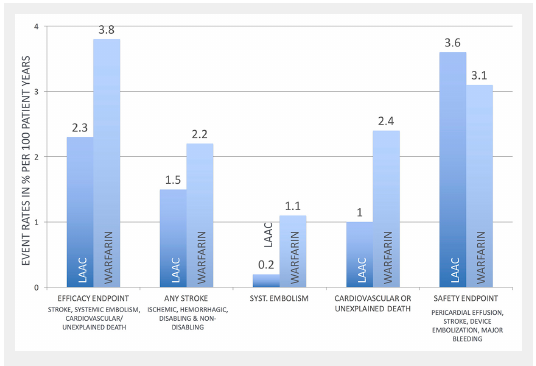
Primary outcomes of the Percutaneous Closure of the Left Atrial Appendage Versus Warfarin Therapy for Prevention of Stroke in Patients with Atrial Fibrillation (PROTECT AF) study [54]. In comparison with warfarin, left atrial appendage closure (LAAC) with the Watchman was superior in preventing death, stroke, and systemic embolism. Due to periprocedural safety events, e.g., severe bleeding as a result of major pericardial effusion, device embolisation and stroke, LAAC with the Watchman device was